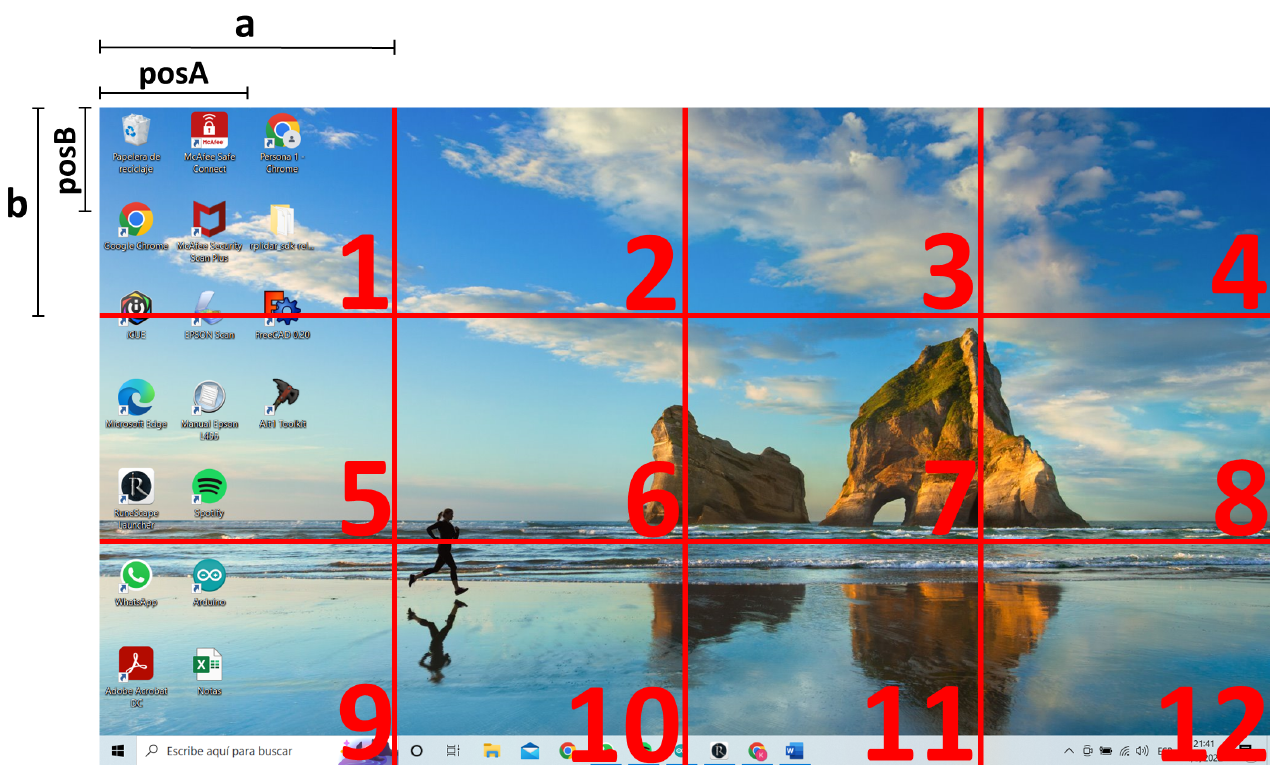
Figure 7. Virtual segmentation of the screen to facilitate control pointer position (quadrant number). “a” is a quarter of the screen width, “b” is a third of the screen height, “posA” is half of “a”, and “posB” is half of